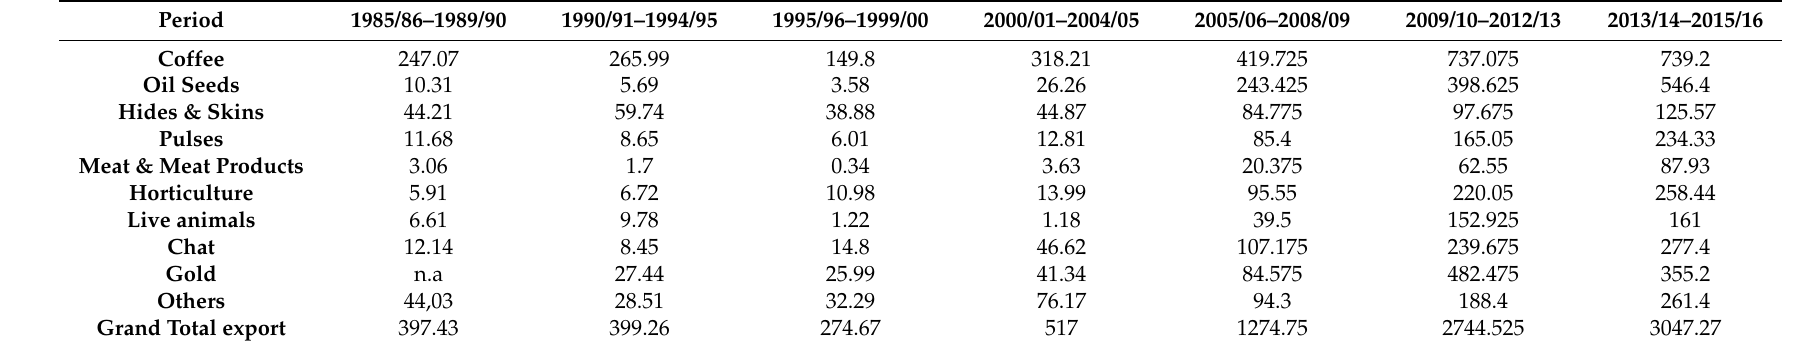
Table 1. Average value of export earnings from major export commodities (in Millions of